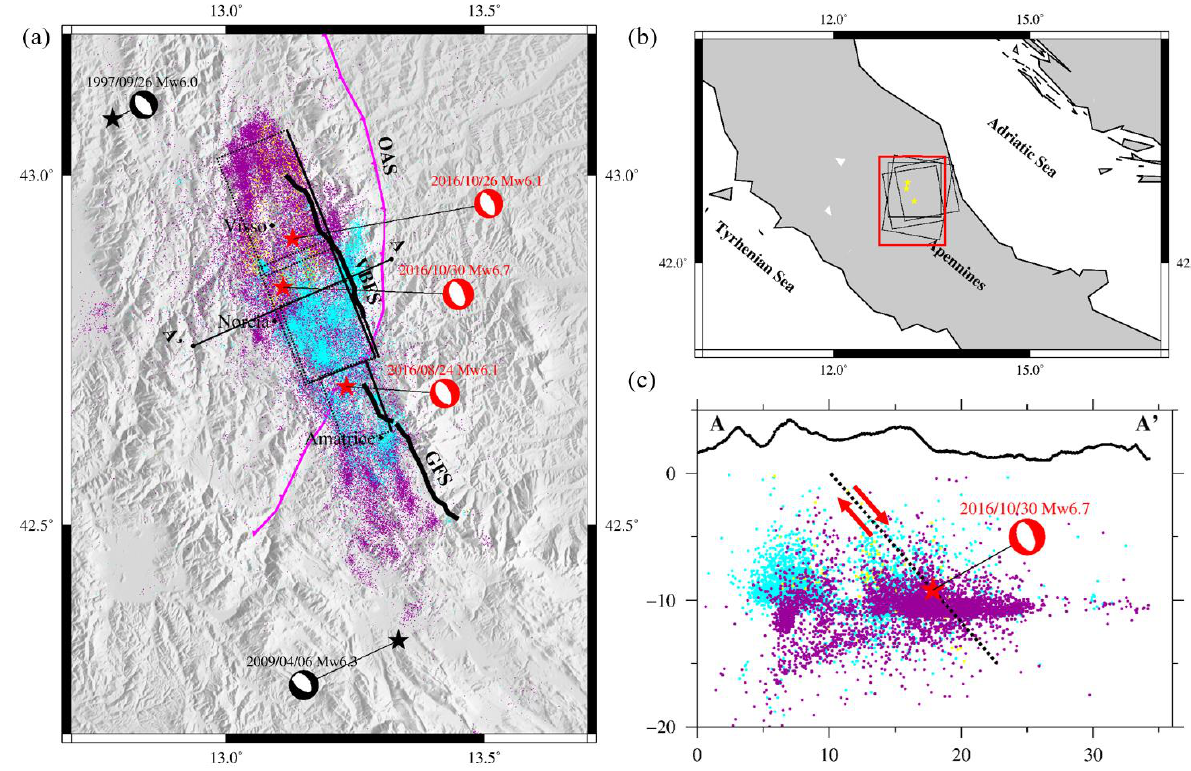
Figure 1. Overview of seismicity, faults and SAR data coverage for the 2016 central Italy earthquake sequence. ( a ) Seismotectonic setting. The three major earthquakes in the sequence are denoted by the red stars and beach ball symbols, and the two recent large historical events are colored in black. The dashed black rectangles represent the surface projection of the fault planes adopted in this study. The bold black lines are the two seismogenic normal fault systems, namely, the Mt. Vettore–Mt. Bove Fault (VBFS) system and the Mt. Gorzano Fault (GFS) system. The pink line shows the simplified trace of the preexisting compressional front named the Olevano–Antrodoco–Sibillini (OAS) thrust. Aftershocks are marked by the small dots with different colors. The blue, purple, and yellow points represent the events taking place between 24 August 2016–26 October 2016, 26 October 2016–30 October 2016, and 30 October 2016–8 October 2017, respectively. ( b ) Map view of the SAR data coverage. The black rectangles represent the coverage of the Sentinel-1A and ALOS 2 SAR data for generating the interferograms. The red rectangle denotes the area shown in ( a ). ( c ) Cross section through A-A’ shown in Figure 1a. The dashed black line represents the fault plane of the 30 October 2016 M w 6.7 Norcia earthquake.